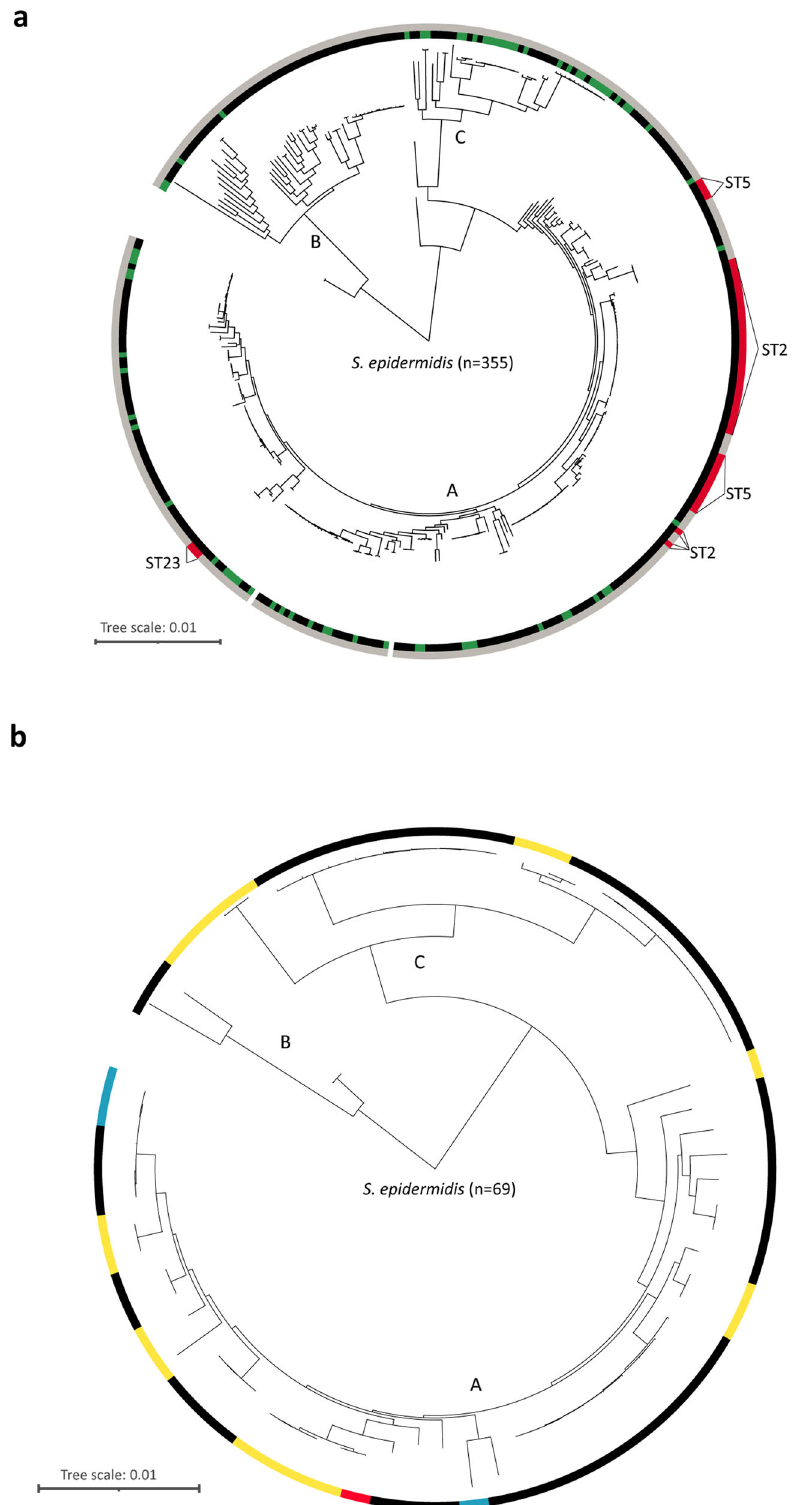
Fig. 3 Phylogeny of S. epidermidis strains obtained in this study. Phylogenetic trees are based on single nucleotide variants (SNVs) of the core genomes. a 286 S. epidermidis strains (genomes taken from RefSeq) ( = black) and 69 strains isolated in this study ( = green). Nosocomial sequence types (ST2, ST5, ST23) ( = red) and non-nosocomial sequence types ( = grey) are depicted. b 69 S. epidermidis strains isolated in this study. Highlighted are strains with mecA gene ( = blue), icaA gene ( = yellow) and one strain with mecA + icaA gene ( =